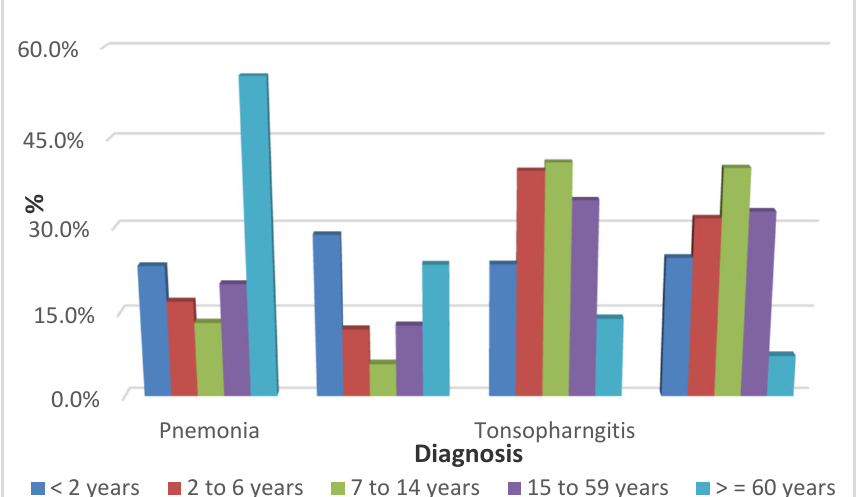
Figure 1. Distribution of antibiotics prescribed in different age groups by diagnosis. Antibiotics 2022 , 11 , x FOR PEER REVIEW